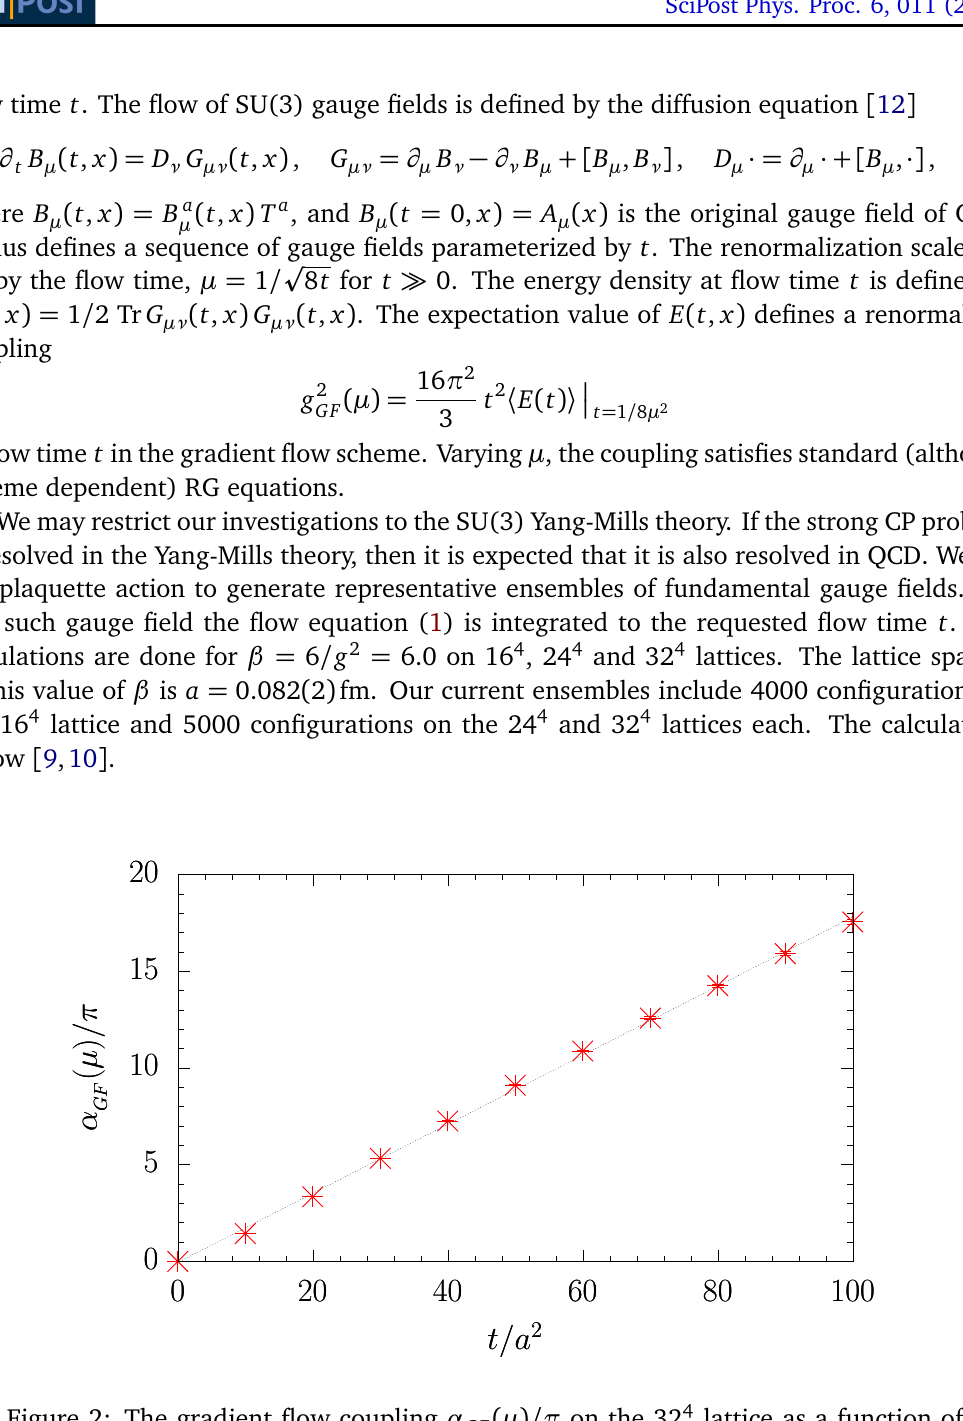
Figure 2: The gradient flow coupling α t / a 2 = 1 / 8 a 2 µ 2 , together with a linear